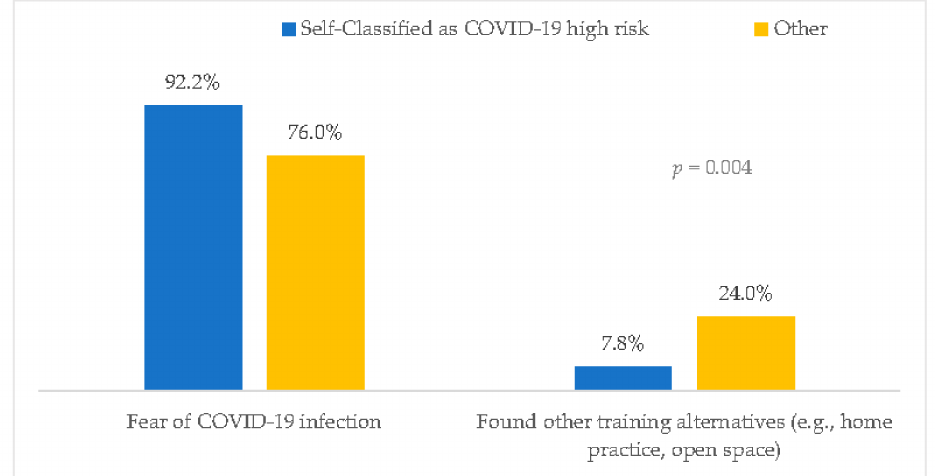
Figure 1. Reported reasons of 321 health club members for not intending to return working out at the club after the closure, according to risk group for COVID-19.